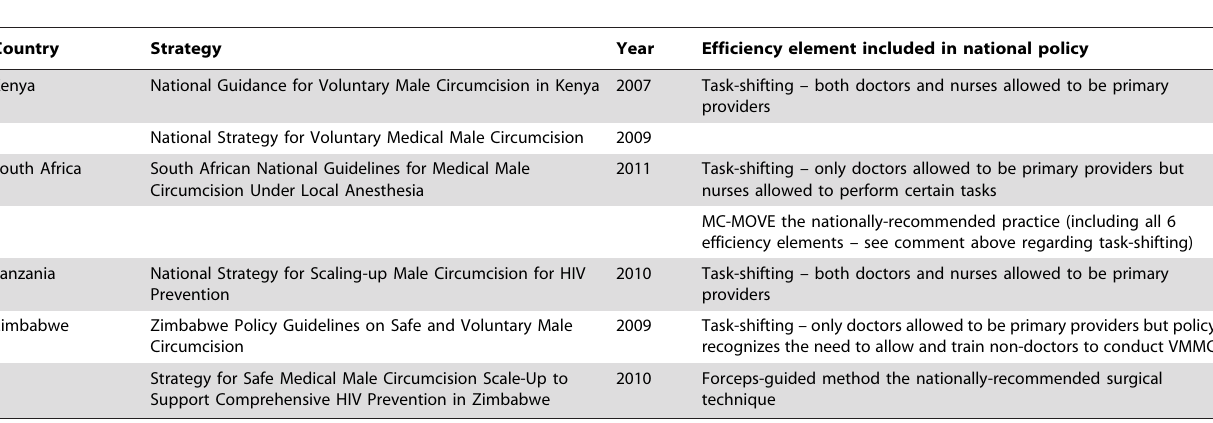
Table 1. VMMC strategies and plans in the four countries, and efficiency elements included in each country’s national guidelines.